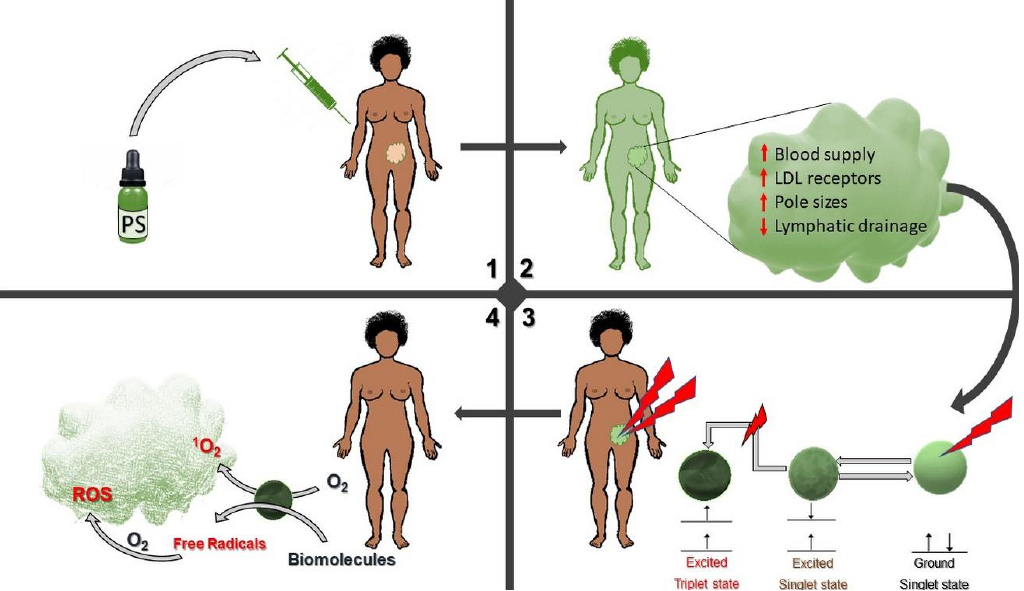
Figure 1. Schematic representation of photodynamic therapy (PDT) of cancer showing the administration of photosensitizer (PS), its actions, and the photodynamic process to achieve a tumor. 1. The PS is administered into the body orally or intravenously. 2. The PS circulates in the vascular system and selectively accumulates in the tumor cells. 3. Light is specifically directed to the tumor region and activates the PS 4. The PS in its activated state causes cytotoxic reactions to repress the tumor. Eventually, after irradiation, either of three mechanisms achieve the therapeutic